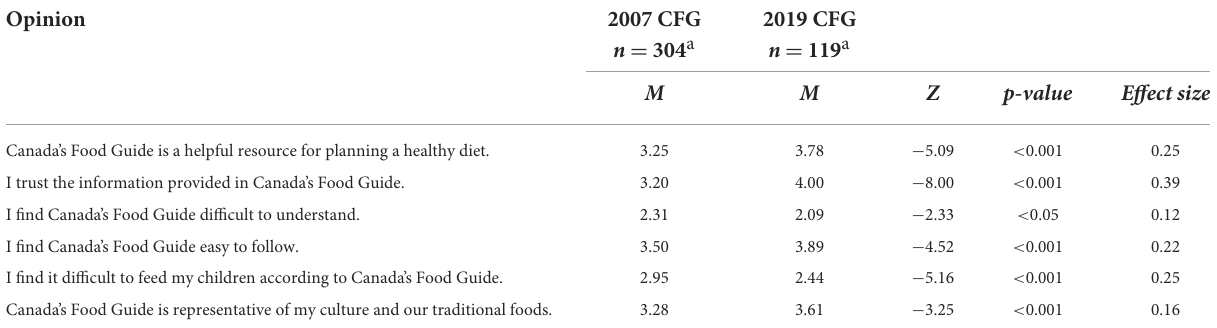
TABLE 2 Parents’ opinions of the 2007 and 2019